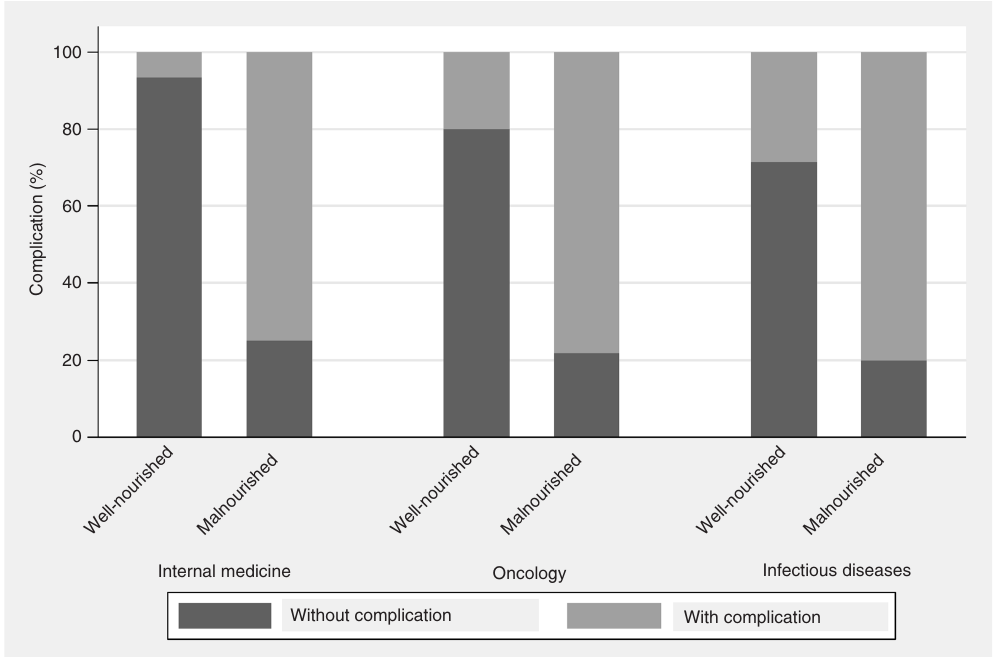
Figure 2. Frequency of infectious and noninfectious complications as a function of nutritional status. Nutritional status was assessed by Subjective Global Assessment (SGA) within the first 48 h of hospitalization. SGA A = well- nourished; SGA B + SGA C = malnourished. Data are reported as percent of